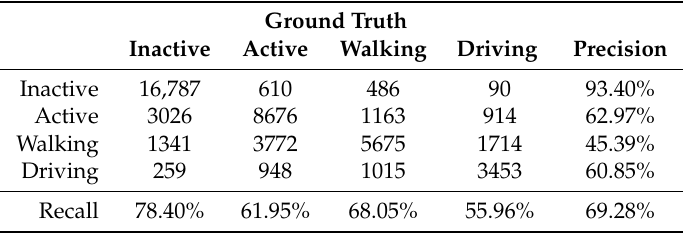
Table 9. Average confusion matrix for the experiments conducted.